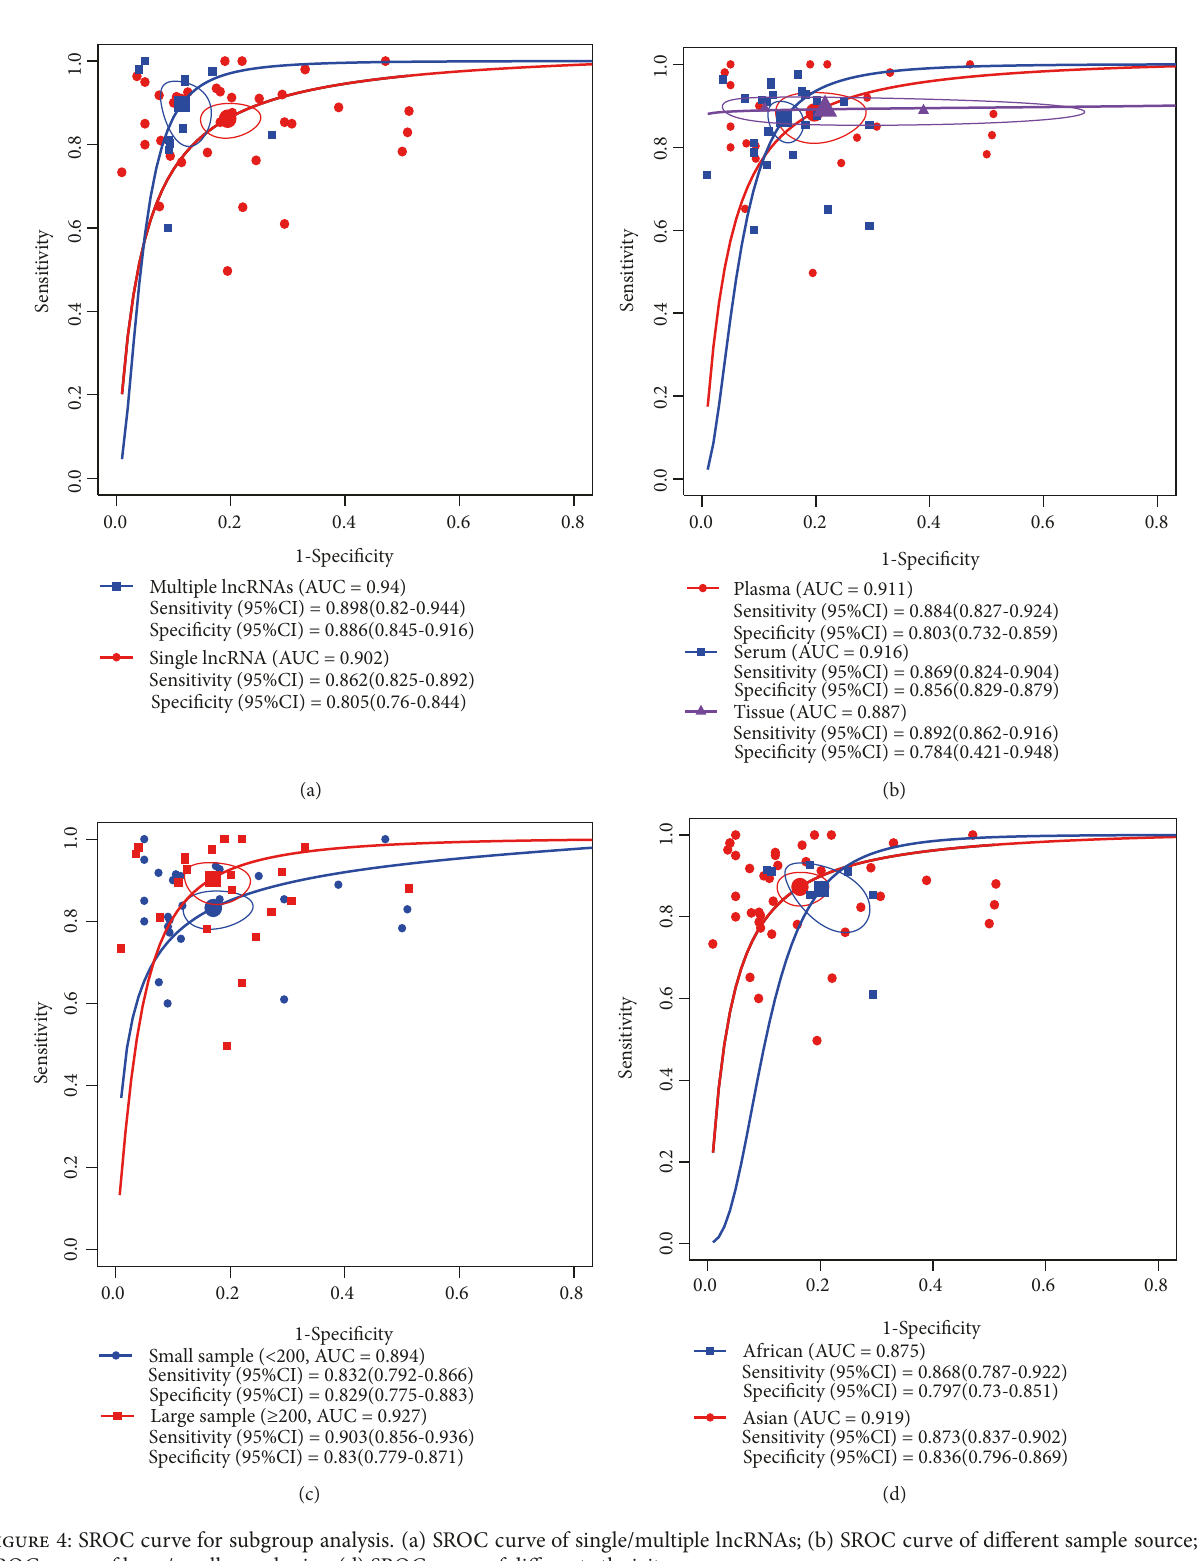
Figure 4: SROC curve for subgroup analysis. (a) SROC curve of single/multiple lncRNAs; (b) SROC curve of different sample source; (c) SROC curve of large/small sample size; (d) SROC curve of different